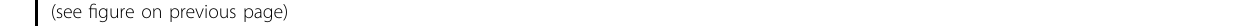
Fig. 2 Treatment with vinpocetine retards adipocyte differentiation by inhibiting adipogenesis-associated cell signaling at early stages and inducing lipolysis and UCP1 expression at late stages. a 3T3-L1 cells were treated with 50 or 100 μ g/ml vinpocetine from day 0, and Oil Red O staining was performed as described in the “ Materials and methods ” on day 2, day 6, or after day 6 of adipocyte differentiation. b 3T3-L1 cells were treated with 50 or 100 μ g/ml vinpocetine, and its effects on the early and late stages of 3T3-L1 differentiation and lipid accumulation were measured using spectrophotometry as described in the “ Materials and methods ” ( n = 3 for each lane). c 3T3-L1 cells were treated with 50 or 100 μ g/ml vinpocetine on day 2 after inducing differentiation, and cell lysates were harvested at 0, 1, 6, 12, and 24 h. The phosphorylated forms of AKT, ERK, JAK2, and STAT3 were detected by western blotting. β -actin was used as a load control. d , e 3T3-L1 cells were treated with vinpocetine, and cell lysates were harvested at 6 days after MDI induction. d The cAMP level was measured using a cAMP direct immunoassay kit as described in the “ Material and methods ” ( n = 3 for each lane). e The phosphorylated and total forms of ATGL, PKA, and HSL were detected by western blotting. f 3T3- L1 cells were treated with 100 μ g/ml vinpocetine, and cell lysates were harvested at days 4 and 6. The protein expression of UCP1 and PGC-1 α was detected by western blotting. β -actin was used as a load control. g OCR was measured in differentiated 3T3-L1 cells in the presence of 2.6 μ M oligomycin, 0.5 μ M FCCP, and 1 μ M rotenone/antimycin A ( n = 3 for each lane). Data are presented as the mean ± SD; * P < 0.05; ** P < 0.01;